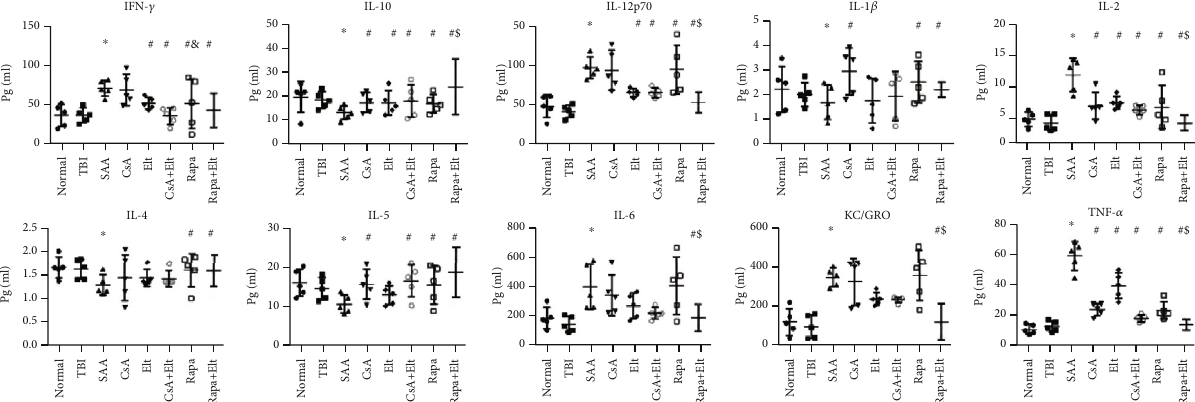
Figure 8: Change of level of plasma cytokines in AA mice after the treatment of rapamycin combined with eltrombopag. ∗ Compared with the NC group ( P < 0 : 05 ). # Compared with the AA group ( P < 0 : 05 ). & Compared with the CsA group ( P < 0 : 05 ). $ Compared with the Rapa group ( P < 0 : 05 ).